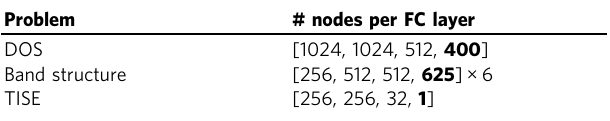
Table 3 Network architecture for G.